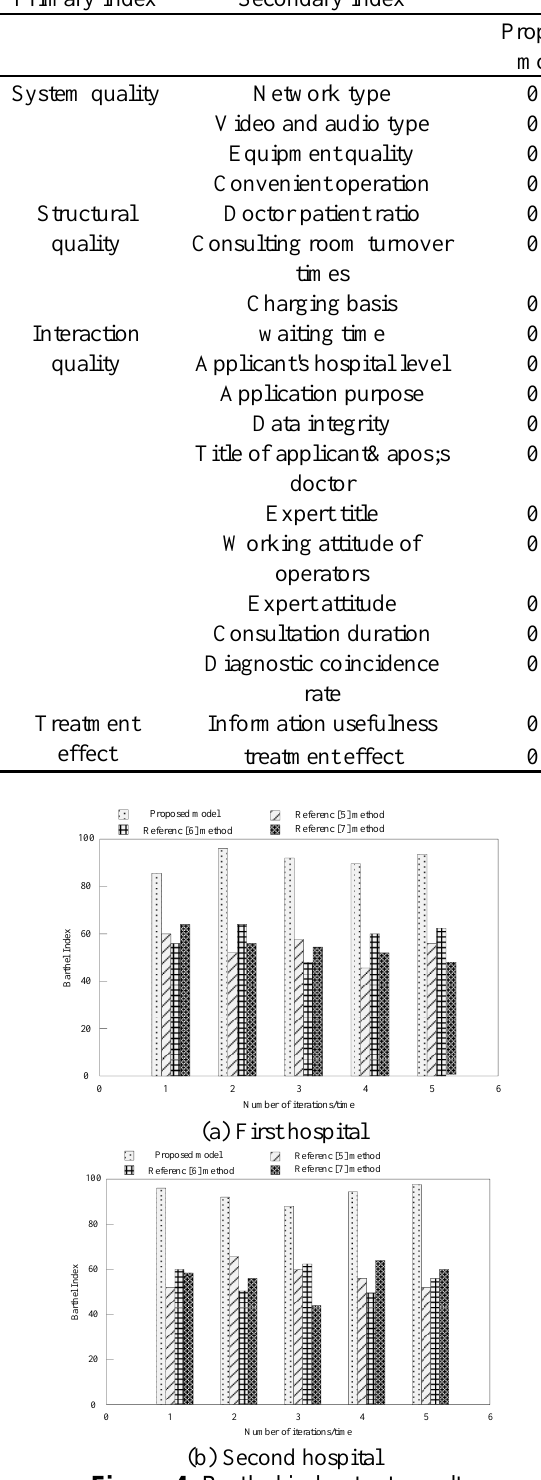
Figure 4. Barthel index test results